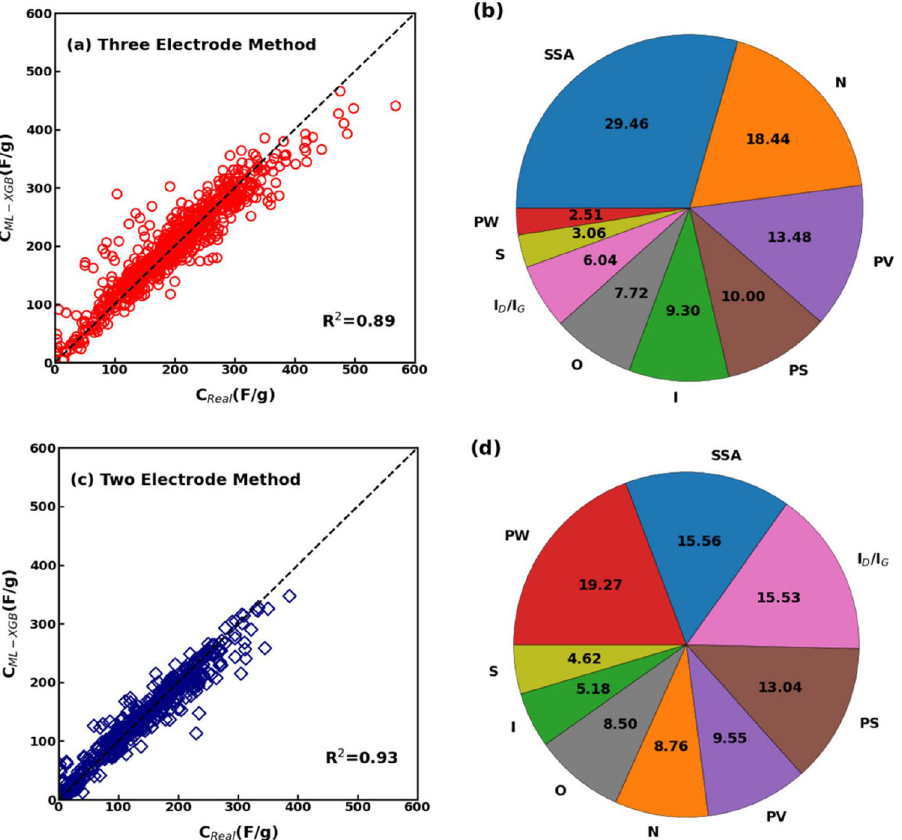
Figure 5. ( a ) Comparison between the predicted and actual capacitance values obtained by the three-electrode method; ( b ) feature analysis for the three-electrode method of testing. ( c ) Comparison between the predicted and actual values for the two-electrode testing method; ( d ) feature analysis for the two-electrode method of